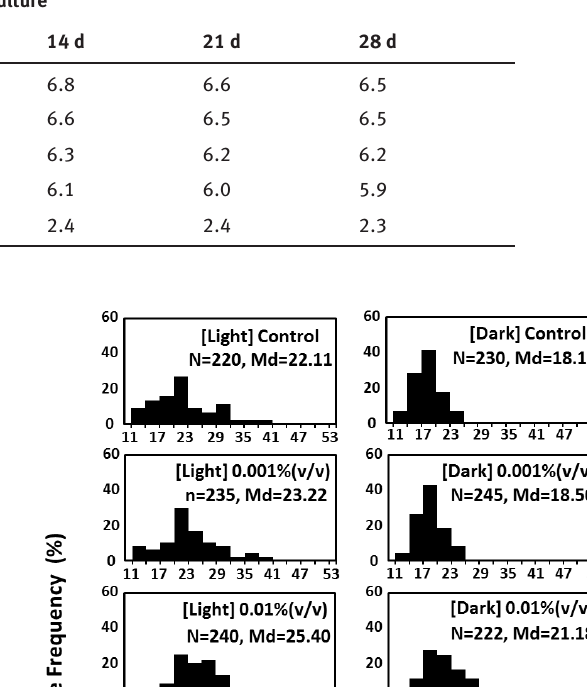
Figure 2: Effect of phytic acid on pigment content of E. gracilis . Asterisks indicate the significant difference ( p < 0.05) between the experimental and control groups.